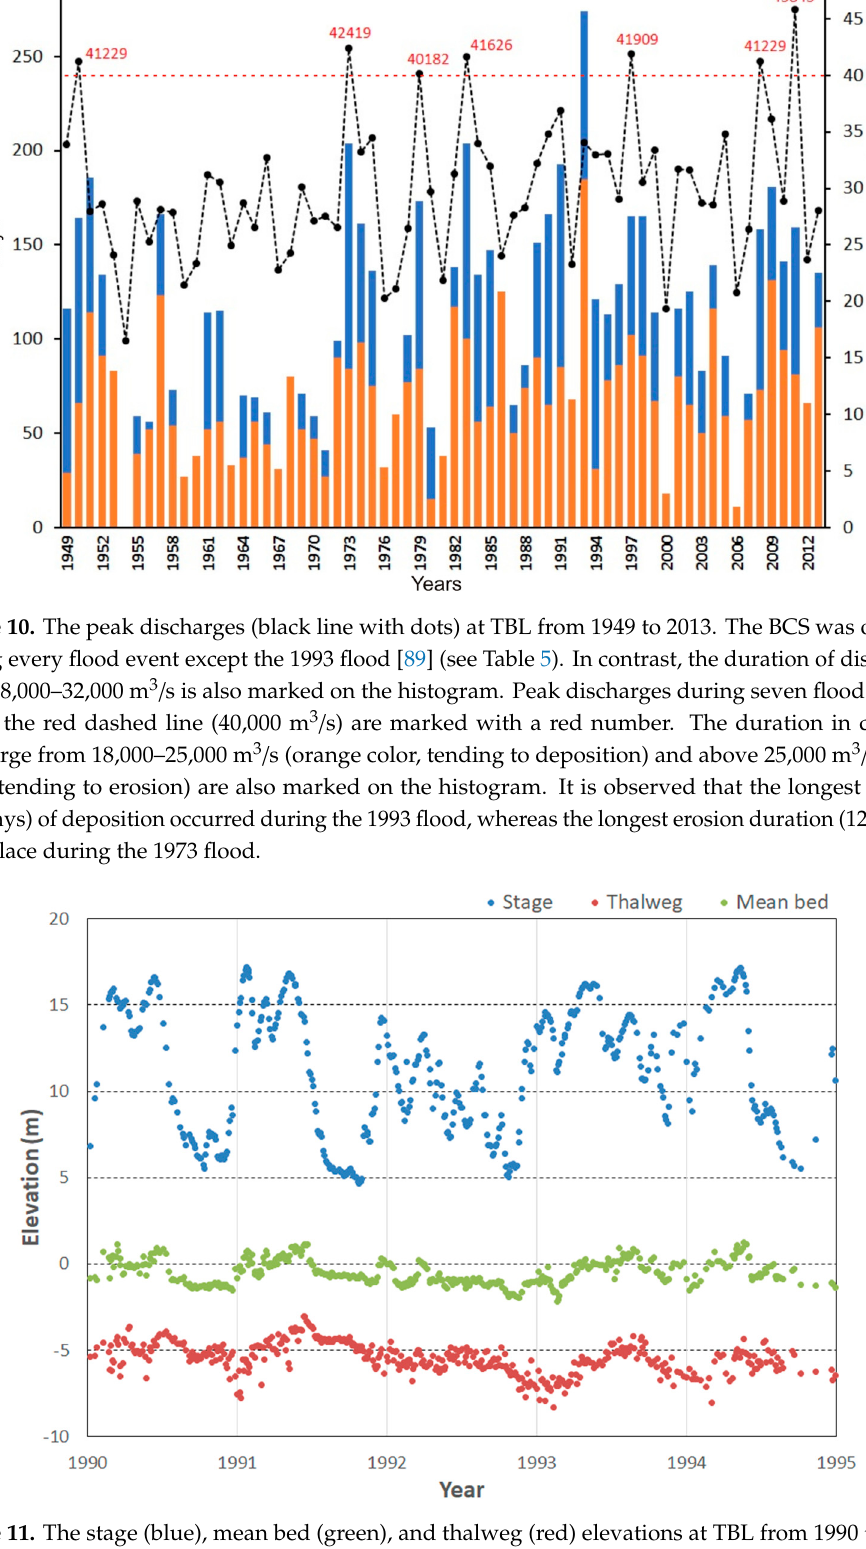
Figure 11. The stage (blue), mean bed (green), and thalweg (red) elevations at TBL from 1990 to 1995 manipulated from data collected by the USACE. Although high stages could be found during the 1993 flood, and ~3 m fluctuations in both mean bed and thalweg elevations occurred, this site had no net aggradation.